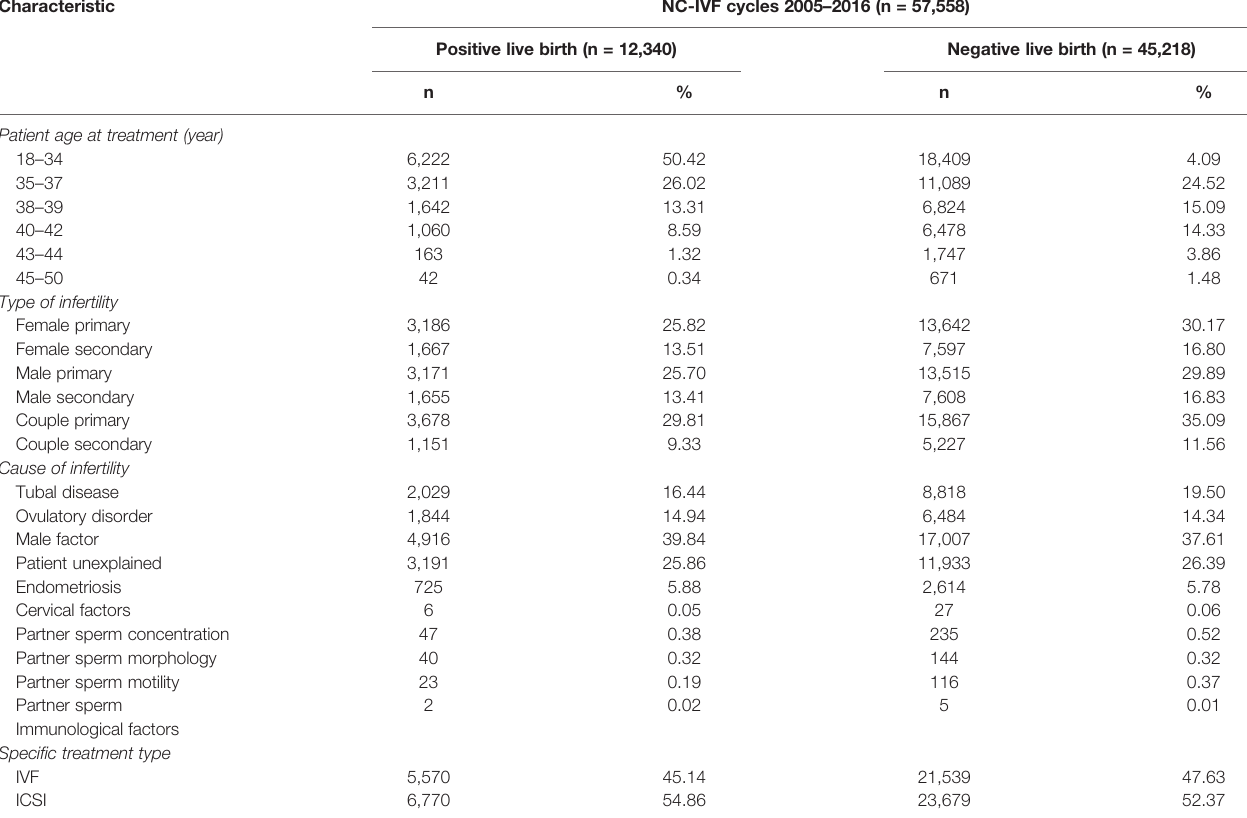
TABLE 2 | Baseline characteristics of NC-IVF cycles. Characteristic NC-IVF cycles 2005 – 2016 (n =